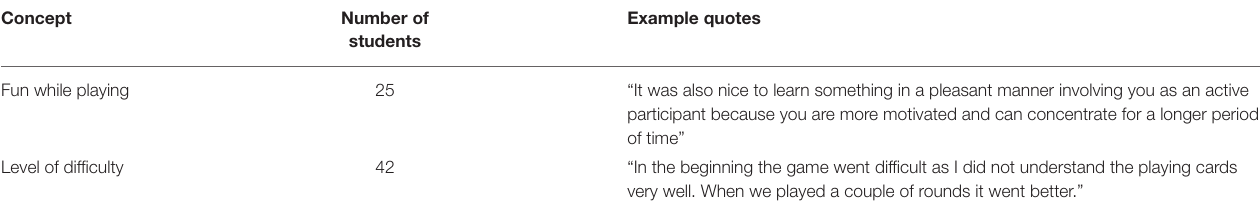
TABLE 10 | Aspects listed in the reflection reports related to game